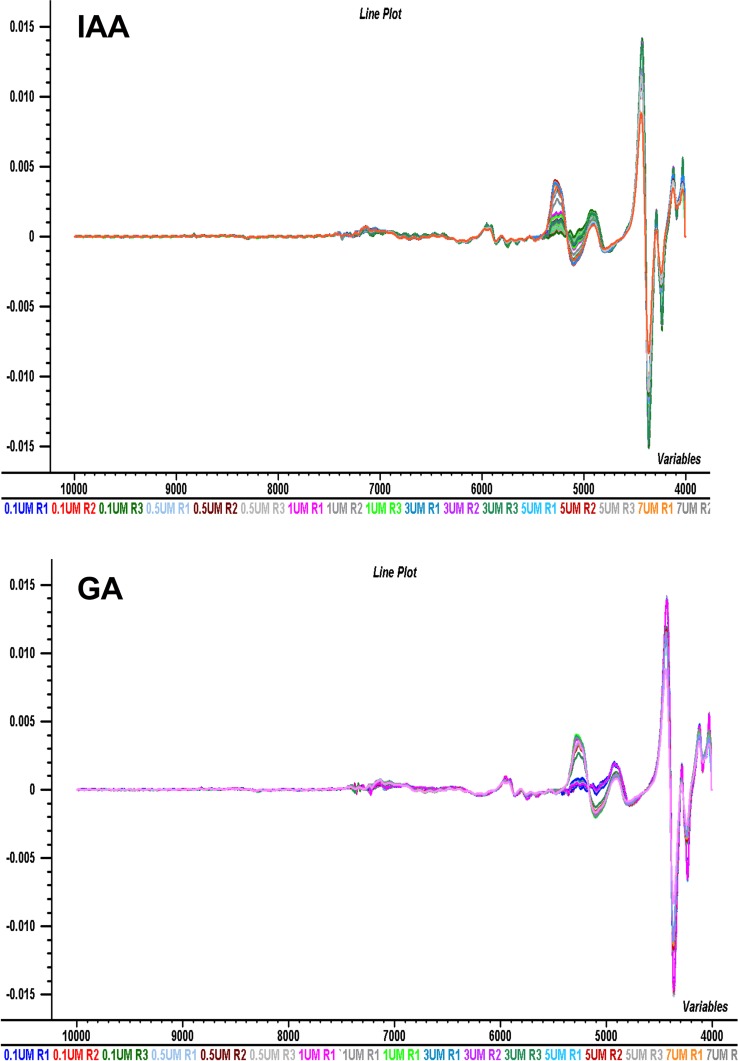
NIRS data spectra for samples.NIRS data spectra for IAA and GA and 13 different populations of Boswellia sacra. Samples are processed after 1st derivative functions with Savitzky-Golay smoothing.